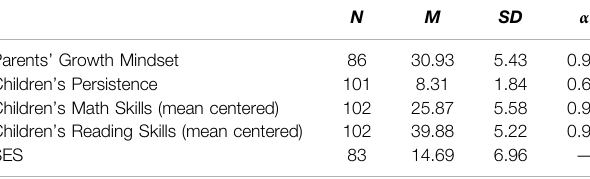
TABLE 2 | Descriptive statistics for study variables.